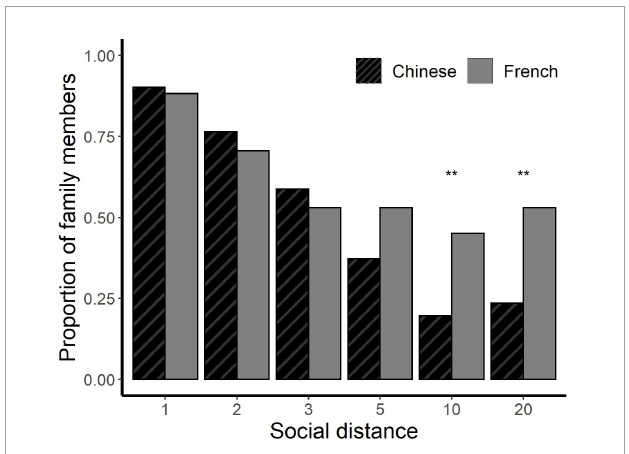
FIGURE2 Inclusion of family at the social distance range 1 ∼ 20. Less participants choose family members as recipients at greater social distances, this decline was more rapid for the Chinese than for the French. * p < 0.05, ** p < 0.01, *** p <